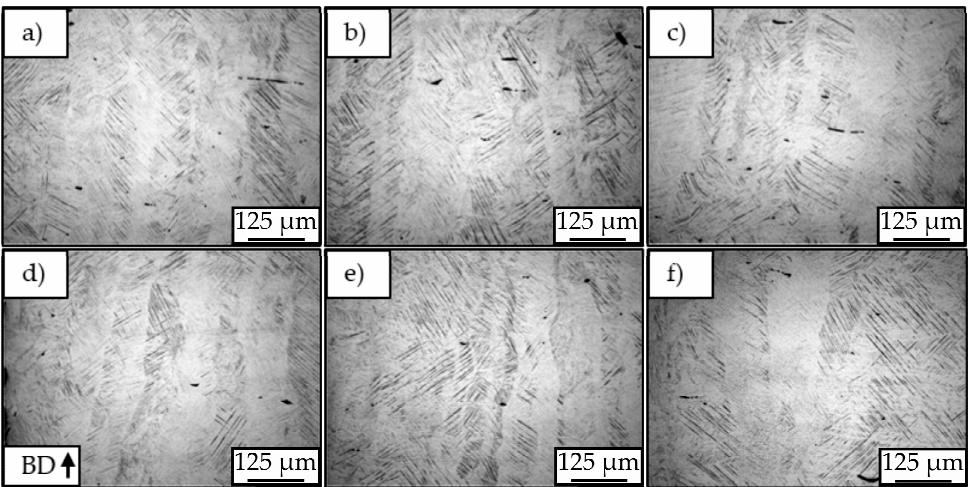
Figure 13. Light microscopy pictures of center ( a , b , c ) and left side surface ( d , e , f ) of batch A Ti ( a , d ), B Ti ( b , e ) and C Ti ( c , f ). Etchant: Kroll’s reagent. B Ti ( b , e ) and C Ti ( c , f ). Etchant: Kroll’s reagent.